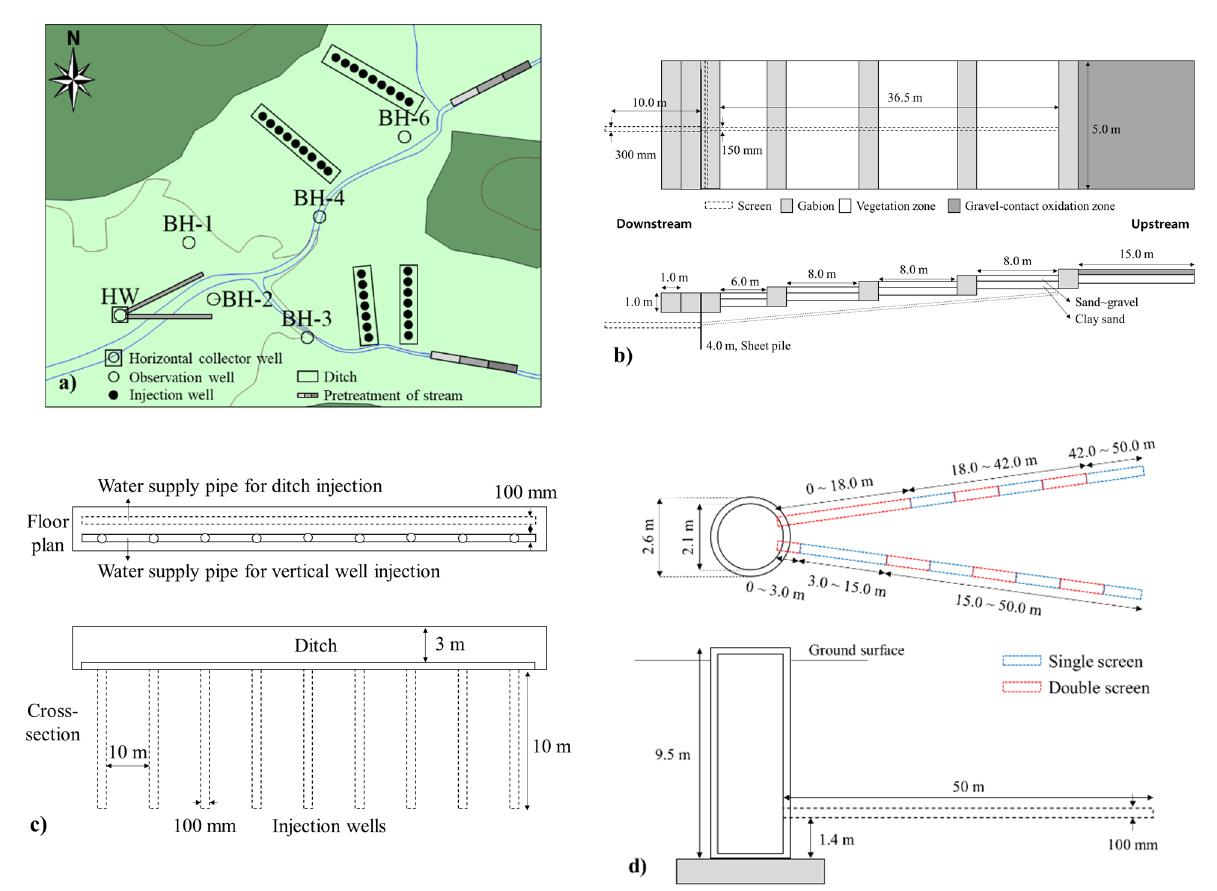
Figure 2. ( a ) Location of hybrid-type artificial recharge system in the study area. ( b ) pretreatment system of stream water. ( c ) the combined artificial recharge structure of ditch and multiple wells and ( d ) collector well: a caisson with two horizontal wells.